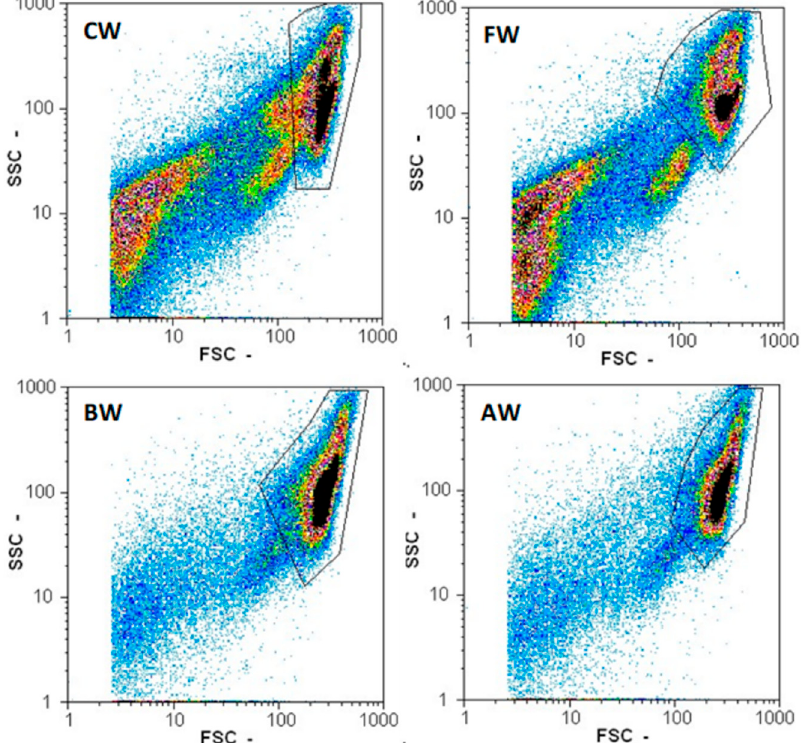
Figure 3. Flow cytometer particle counts for the forward scatter (FSC) and the sideward scatter (SSC) of four fermentations with different pretreated wort: CW, control wort; FW, filtered wort; BW, boiled wort; and AW, autoclaved wort. Black boxes display the area that was considered for the yeast cell count and viability. Darker colours indicate a higher count in the area of the graph.